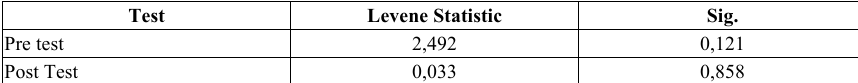
Table 7. Homogeneity Test Result